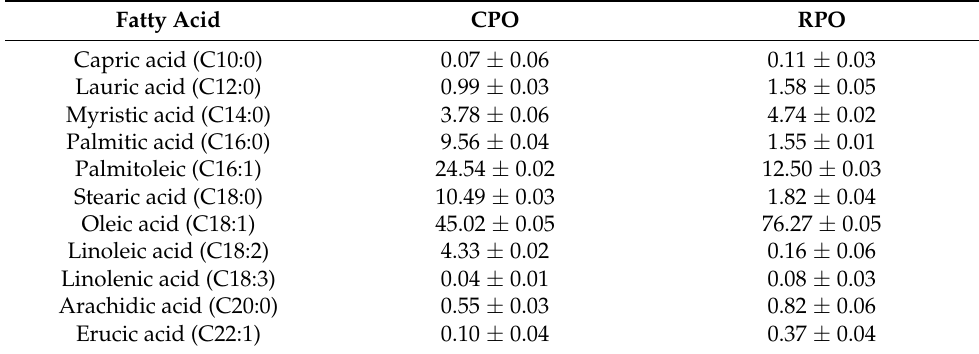
Table 1. Fatty acid composition of crude palm oil (CPO) and refined palm oil